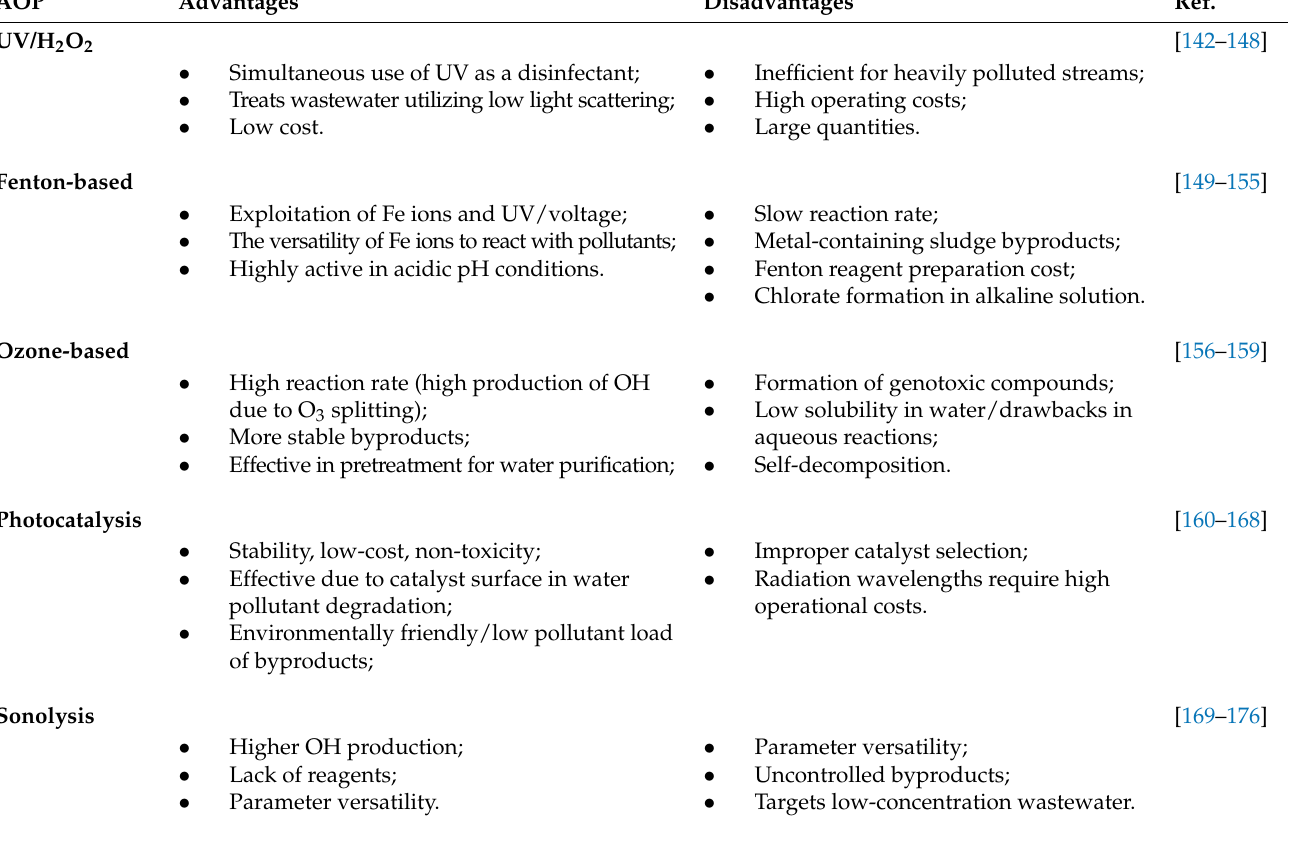
Table 3. Advantages and disadvantages of